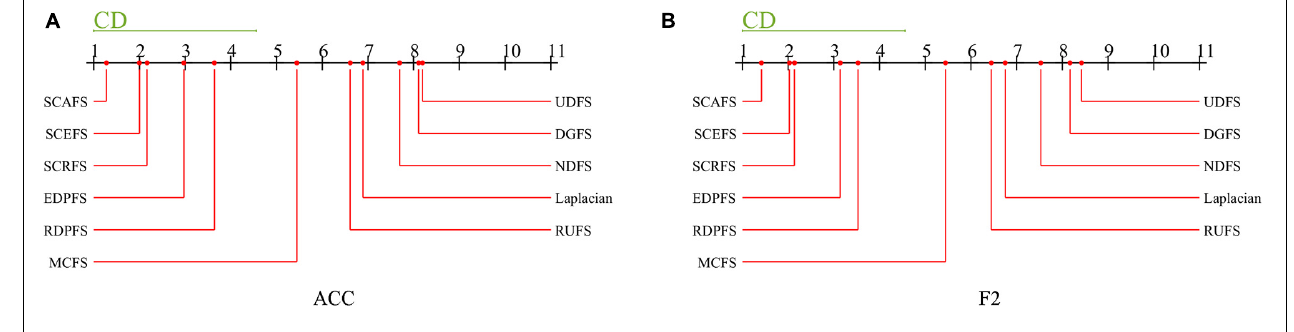
FIGURE 8 | Comparison of unsupervised feature selection algorithms against each other on maximal mean Acc and F2 with Nemenyi’s test, (A) Acc, (B)